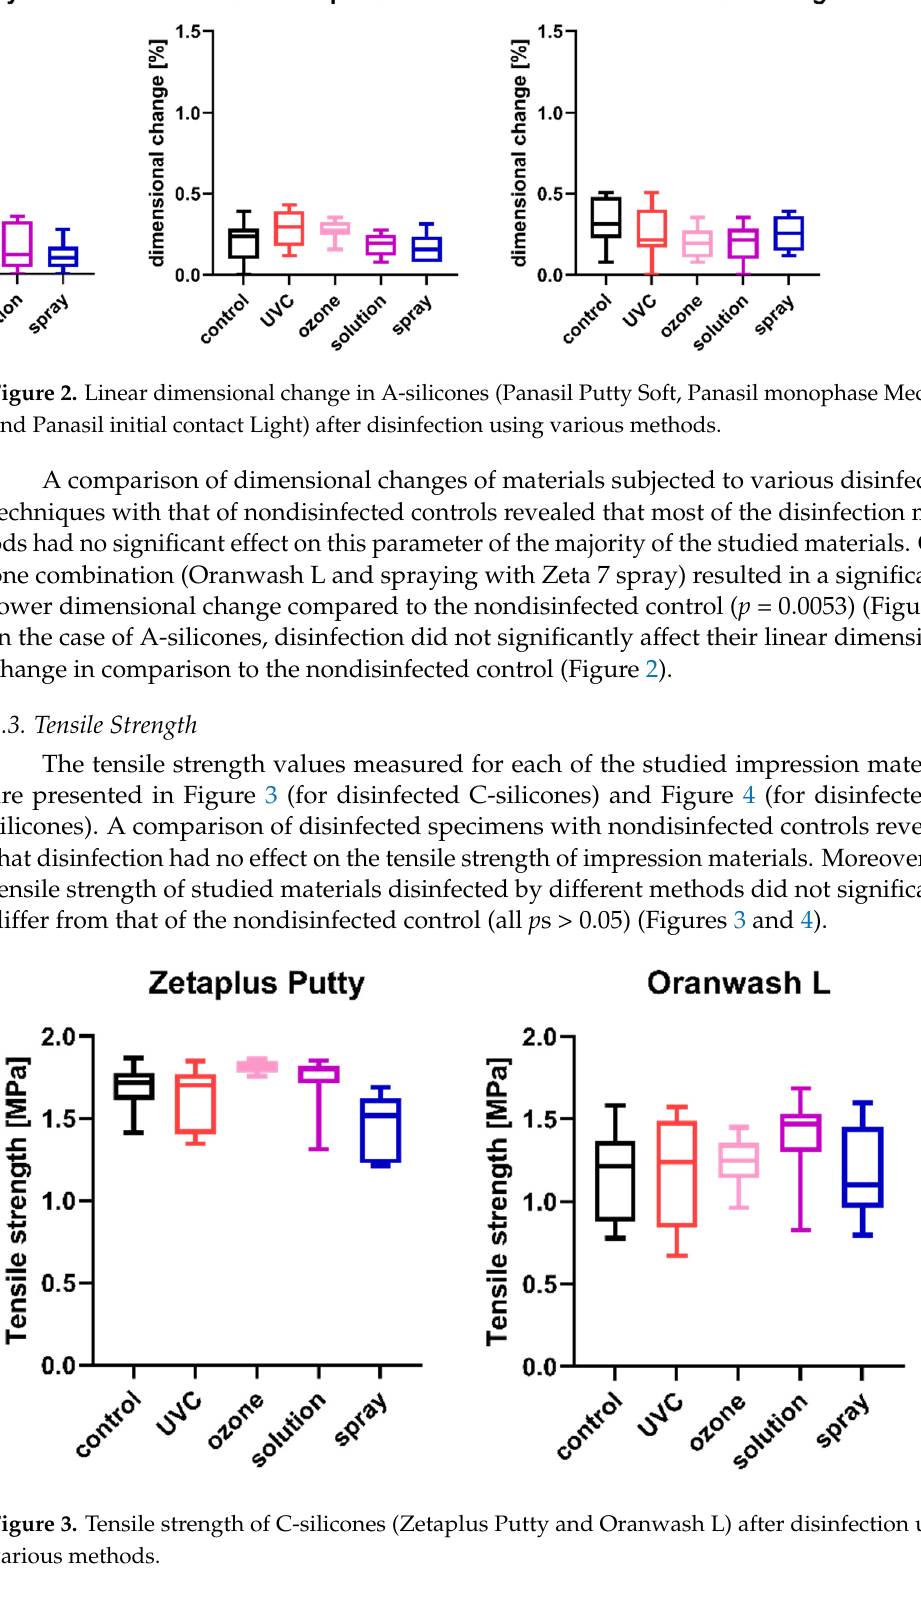
Figure 1. Linear dimensional change in C-silicones (Zetaplus Putty and Oranwash L) after disinfec- tion using various methods; ** p < 0.01 for the comparison between the study (disinfected) groups and the control (nondisinfected) group.